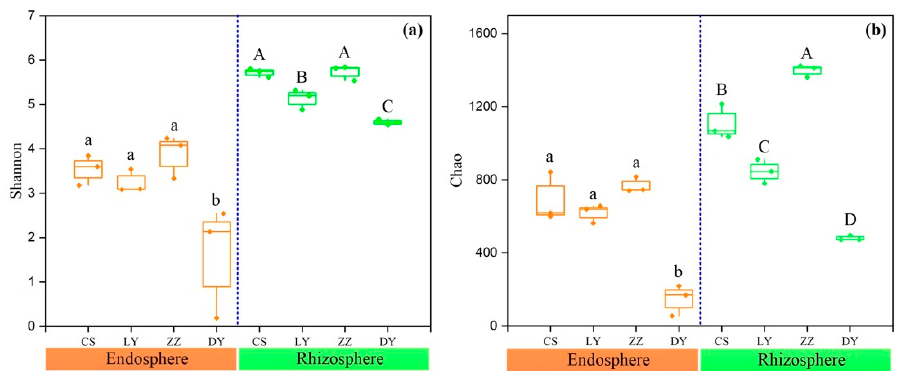
Figure 1. Alpha diversity of endosphere and rhizosphere bacterial microbial communities of C . communis at the four sampling sites. ( a ) Shannon’s diversity, ( b ) Chao richness. The horizontal bands within boxes represent the median and whiskers represent the minimum and maximum values. Data are analyzed by means of one-way ANOVAs and different small letters on the bars indicate significant differences at p < 0.05.